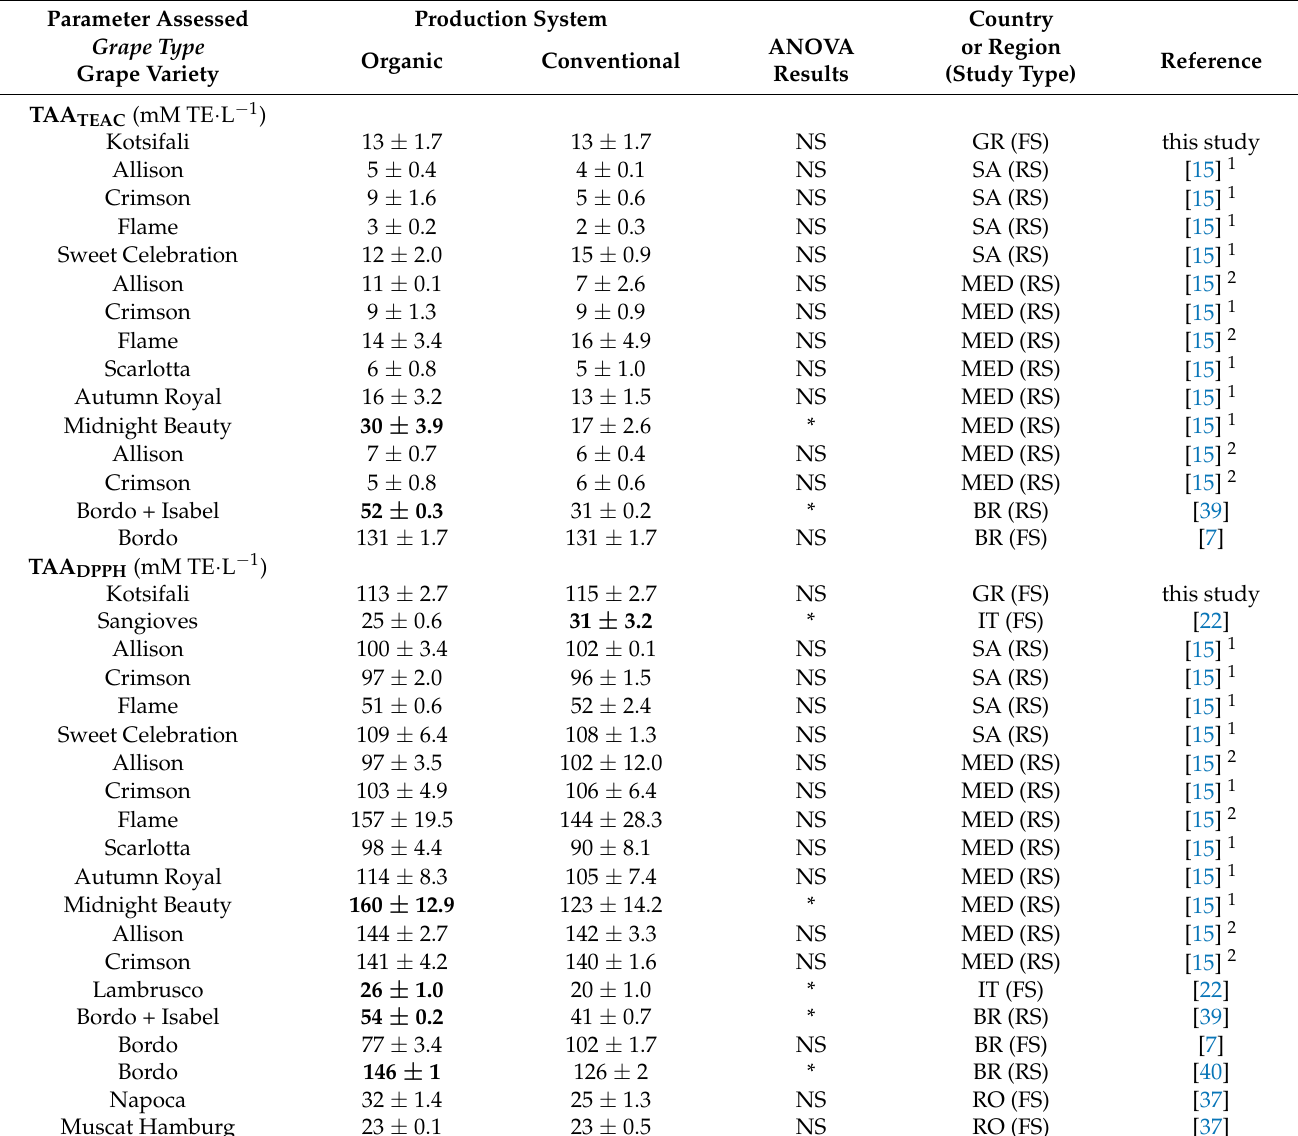
Table 4. Total antioxidant activity/capacity reported for different red/black grape varieties grown in organic and conven- tional production systems in different